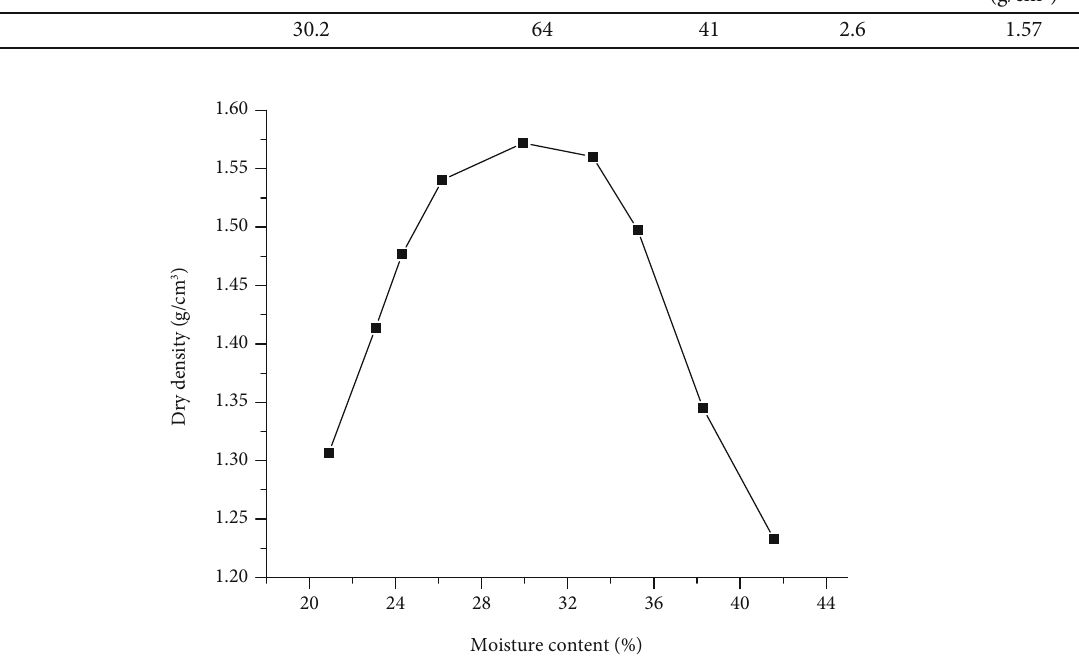
Table 1: Physical properties of red clay.